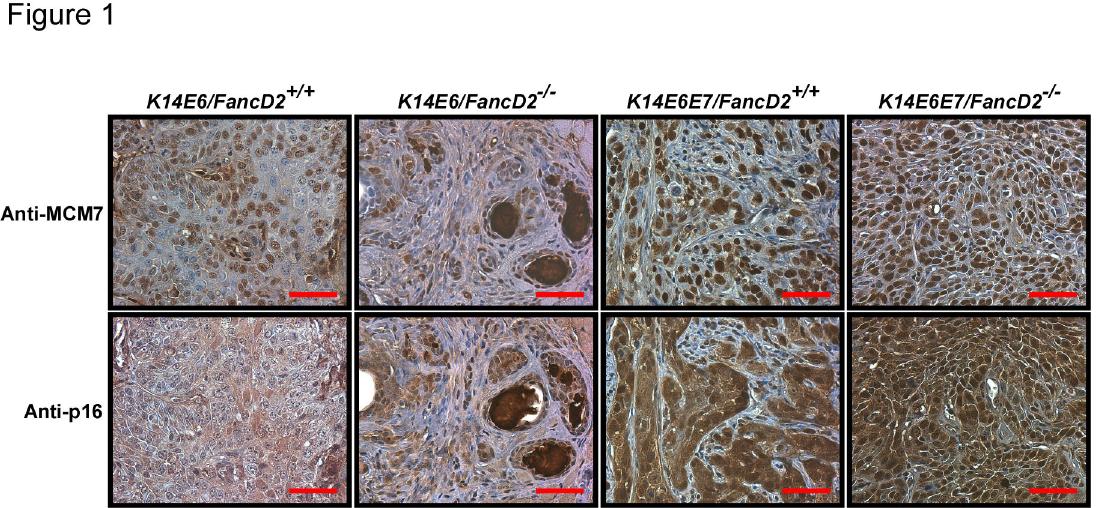
Figure 1. Expression of MCM7 and p16, two biomarkers in carcinomas arising on the tongue and esophagus in K14E6 and K14E6E7 mice on the fancD2 -sufficient and -deficient backgrounds. Shown are representative immunohistochemistry images from sections stained with anti-MCM7 (brown nuclei) and anti-p16 (brown nuclei) antibodies and counterstained with hematoxylin (blue nuclei). Scale bar, 50